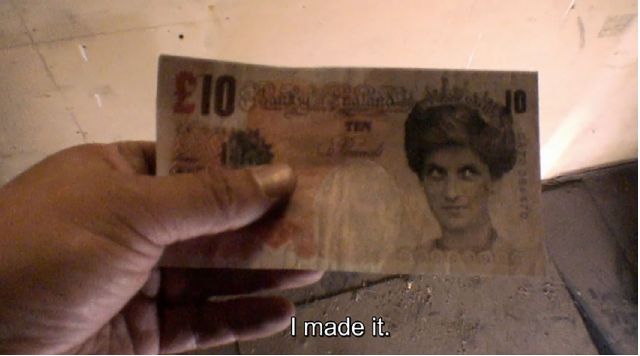
Fig. 3 Banksy, Exit Through The GiftShop , 2010, movie